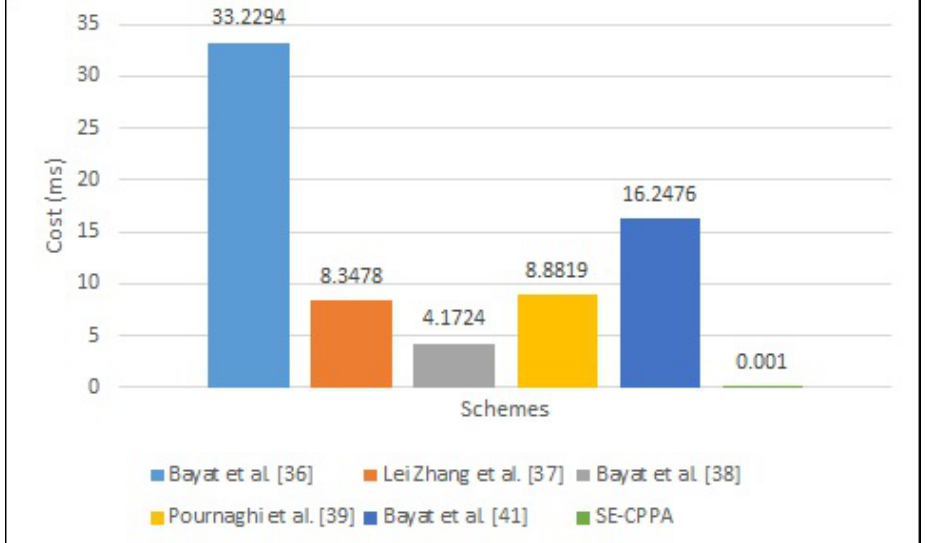
Figure 5. The comparison of message signing